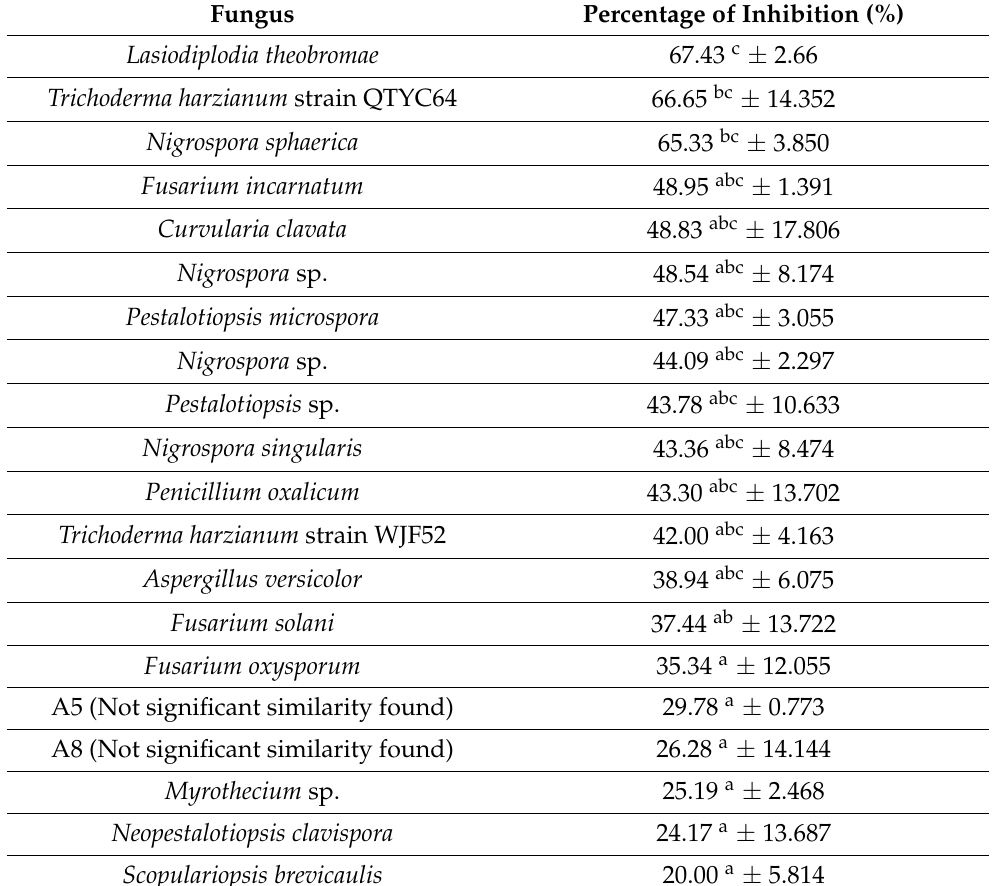
Table 2. Average Percentage of Inhibitory of Phylloplane Fungi against Fusarium oxysporum f. sp. cubense in seven